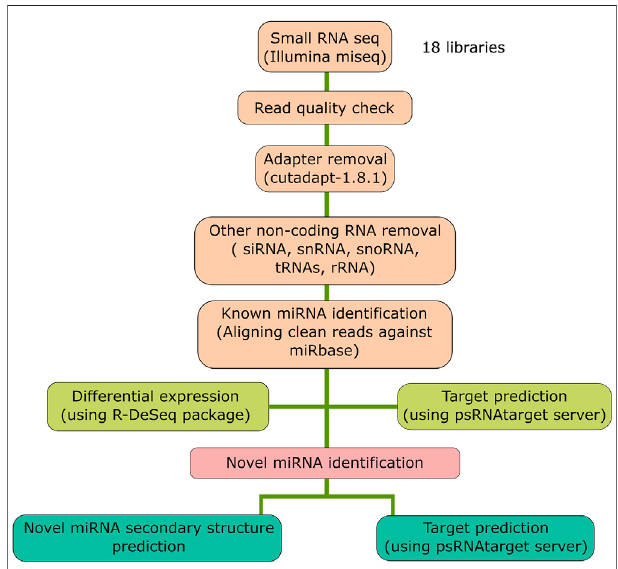
FIGURE 1 | Schematic representation of the bioinformatics analysis pipeline. The fl ow chart represents the steps followed for the small RNA- sequencing data analysis for the 18